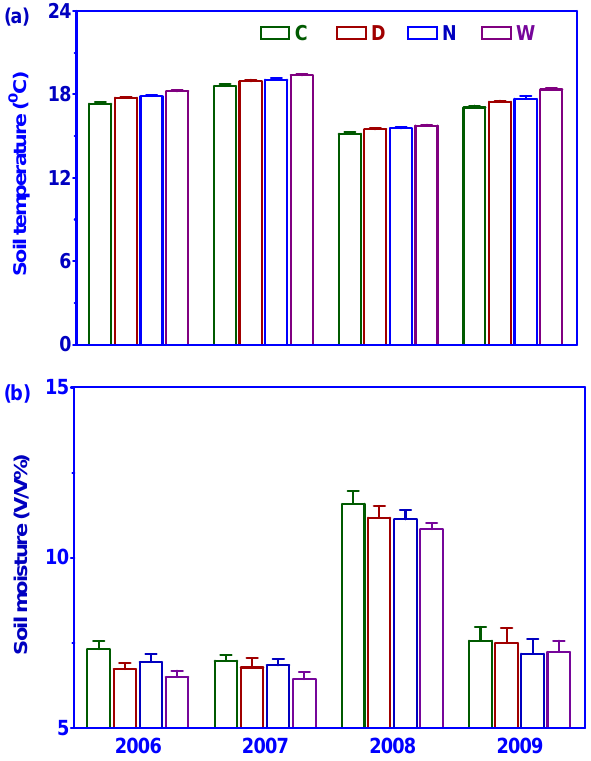
Fig. 1. Effects of control (C) and day warming (D), night warming (N) and continuous warming (W) on temperature (a) and moisture (b) in the soil layer of 0-10cm over the experimental period from 2006 to 2009. Data are mean ± SE of six